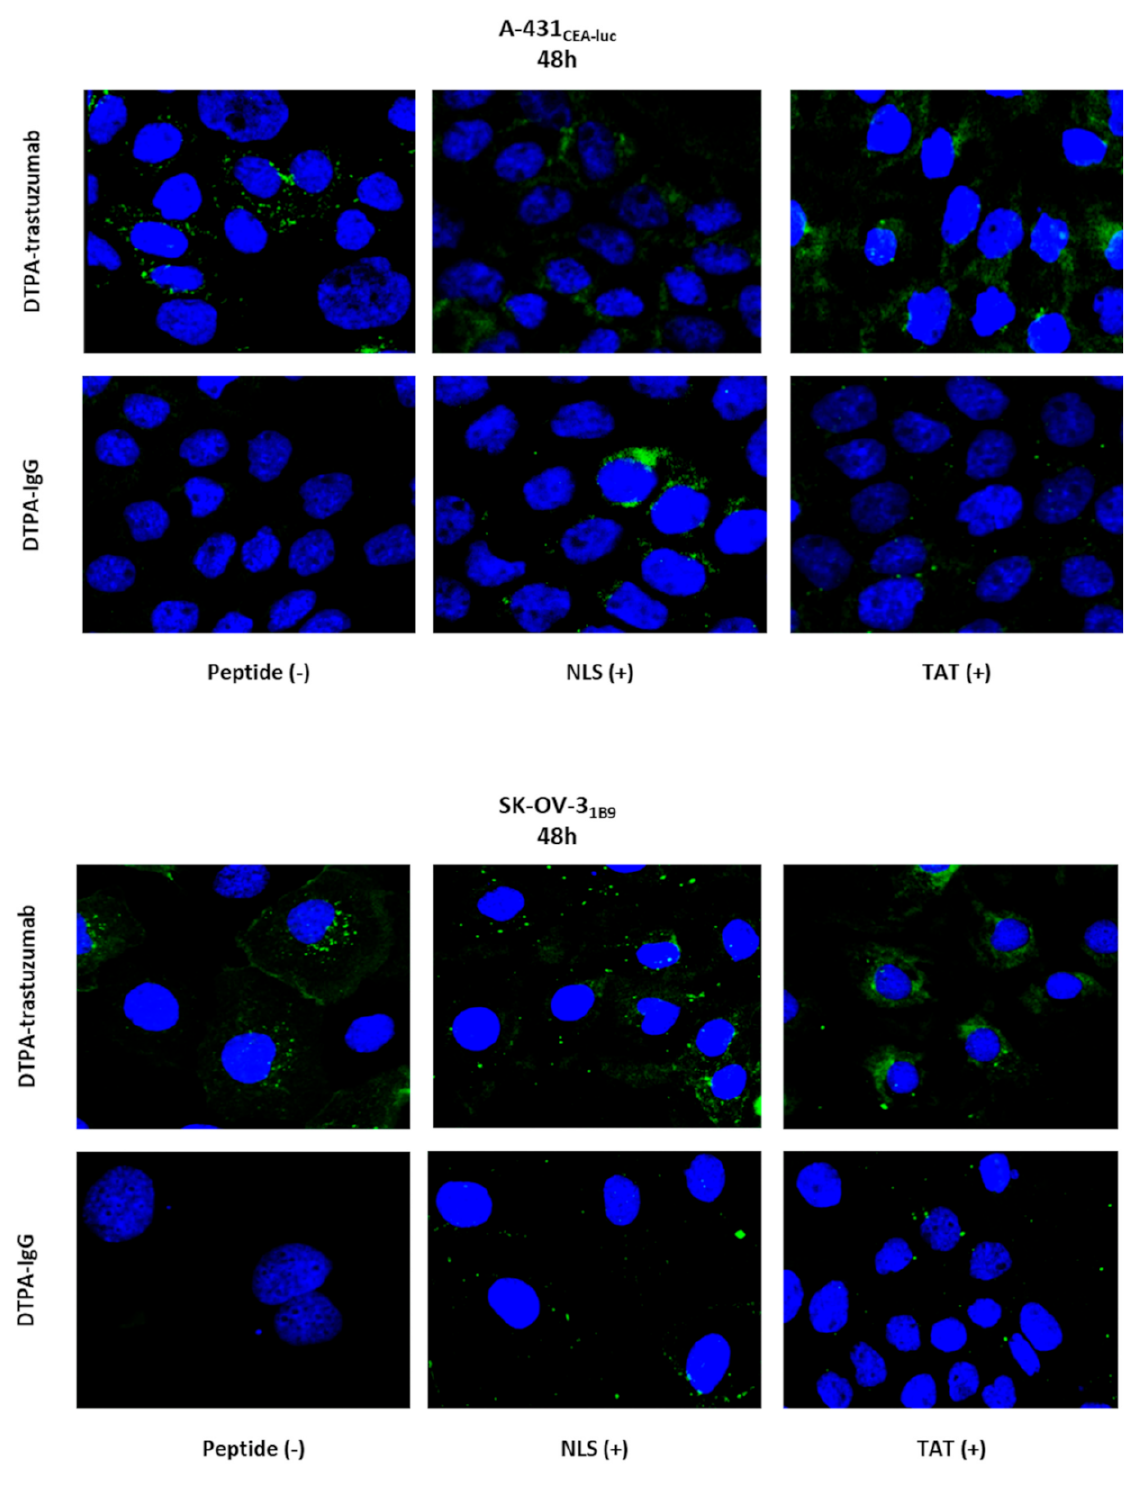
Figure 6. Immunofluorescence analysis of immunoconjugates 48 h after incubation onset. A-431 CEA-luc and SK-OV-3 1B9 cells were incubated with DTPA-trastuzumab, DTPA-trastuzumab-NLS 5-10 , DTPA-trastuzumab-TAT 1-3 , or DTPA-IgG, DTPA-IgG-NLS 5-10 , or DTPA-IgG-TAT 1-3 (10.8 µ g/mL) for 48 h. Cells were fixed, permeabilised and incubated with an AlexaFluor-488-labelled anti-human IgG antibody. Images were acquired using an × 63 or × 40